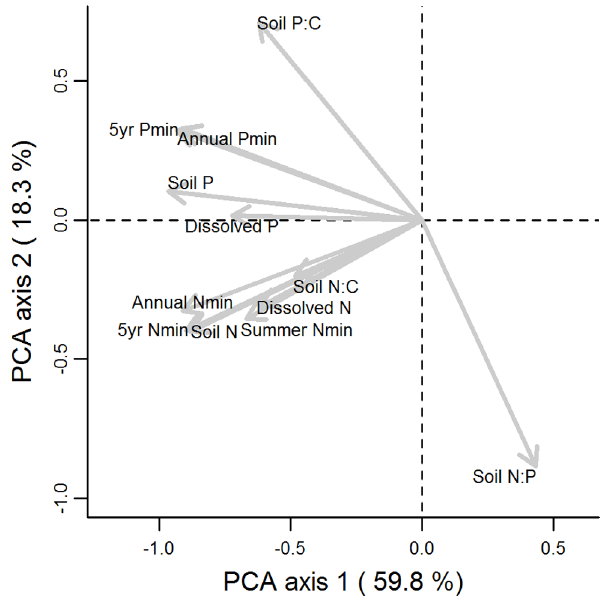
Figure 3. Principal Component Analysis (PCA) of 12 soil fertility measures for 134 plots.